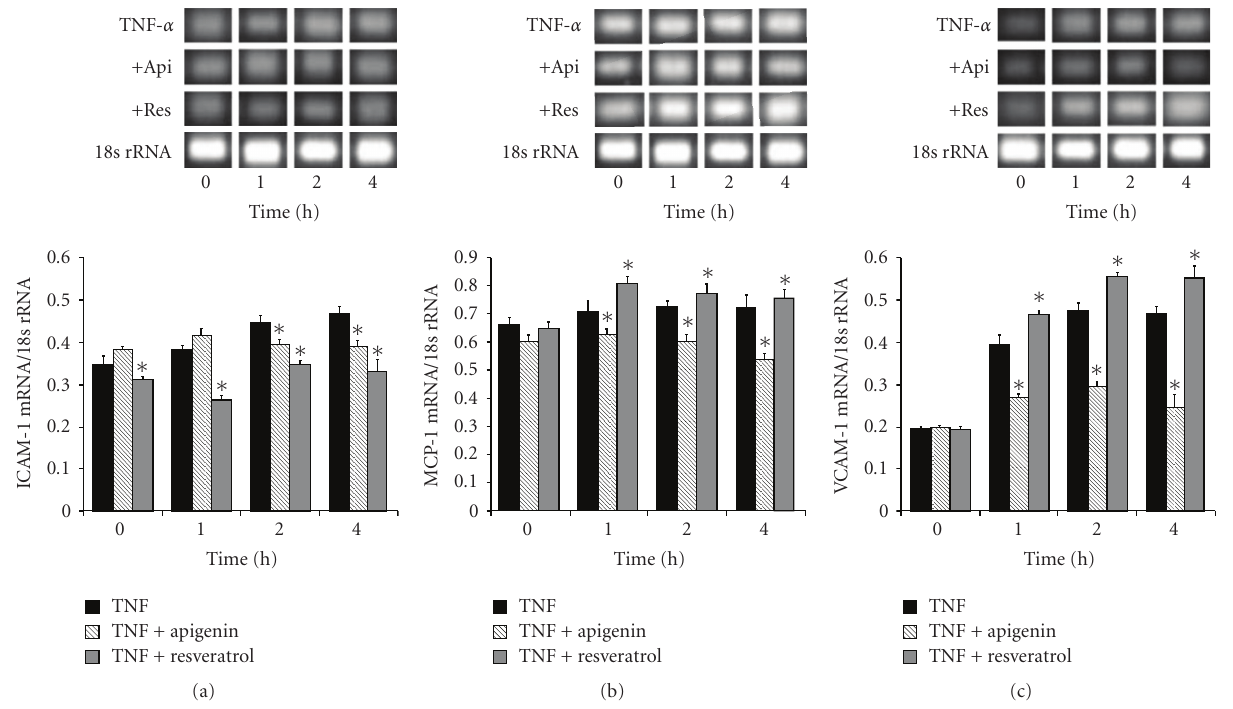
Figure 3: The e ff ects of apigenin and resveratrol on the TNF- α -induced expression of ICAM-1, MCP-1, and VCAM-1 in astrocytes isolated from SHRSP/IZM. Time course: the astrocytes isolated from SHRSP/IZM were washed with FBS-free DMEM, before (10 μ M) TNF- α and apigenin or resveratrol were added. The astrocytes were cultured for 1, 2, or 4 hours. The ICAM-1(a), MCP-1 (b), and VCAM-1 (c) mRNA measurements were carried out as described in Figure 1 and in the text. The bars represent the mean ± SD ( n = 4). Asterisk ( ∗ ): P < . 05 compared with the expression level of TNF- α value at the same time. +Api; apigenin, +Res: